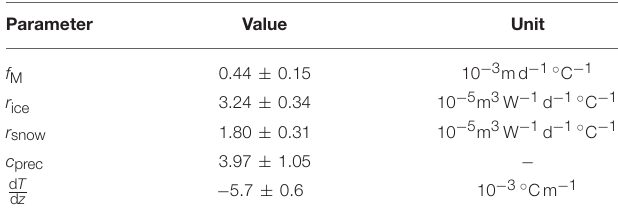
TABLE 3 | Average of calibrated model parameters over the 10 year study